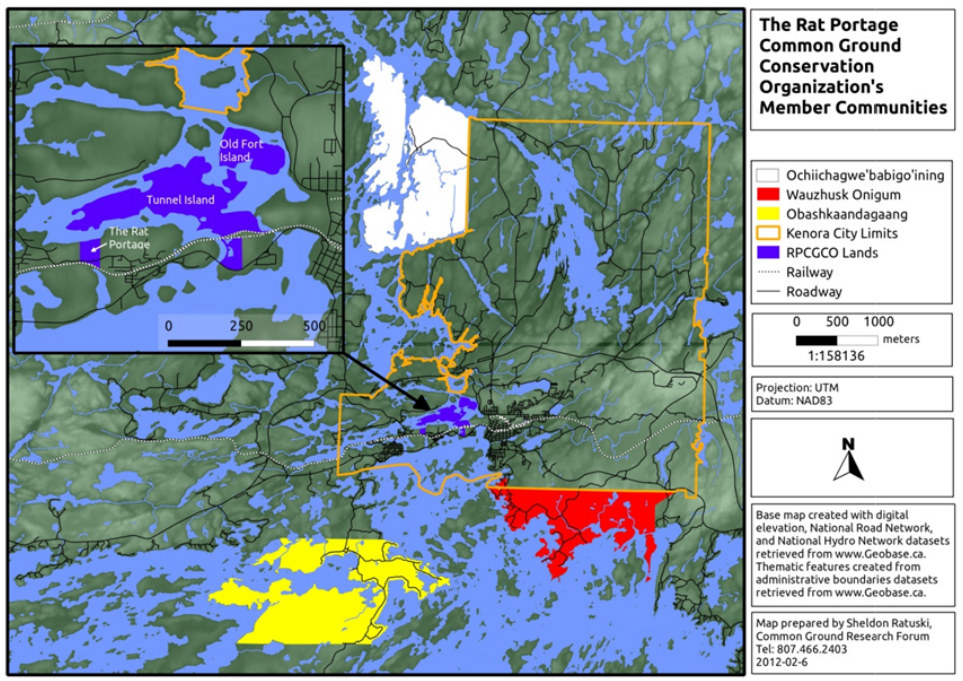
Figure 1.2 – Location of the ‘Common Ground’ Member Communities and the Rat Portage-Tunnel Island